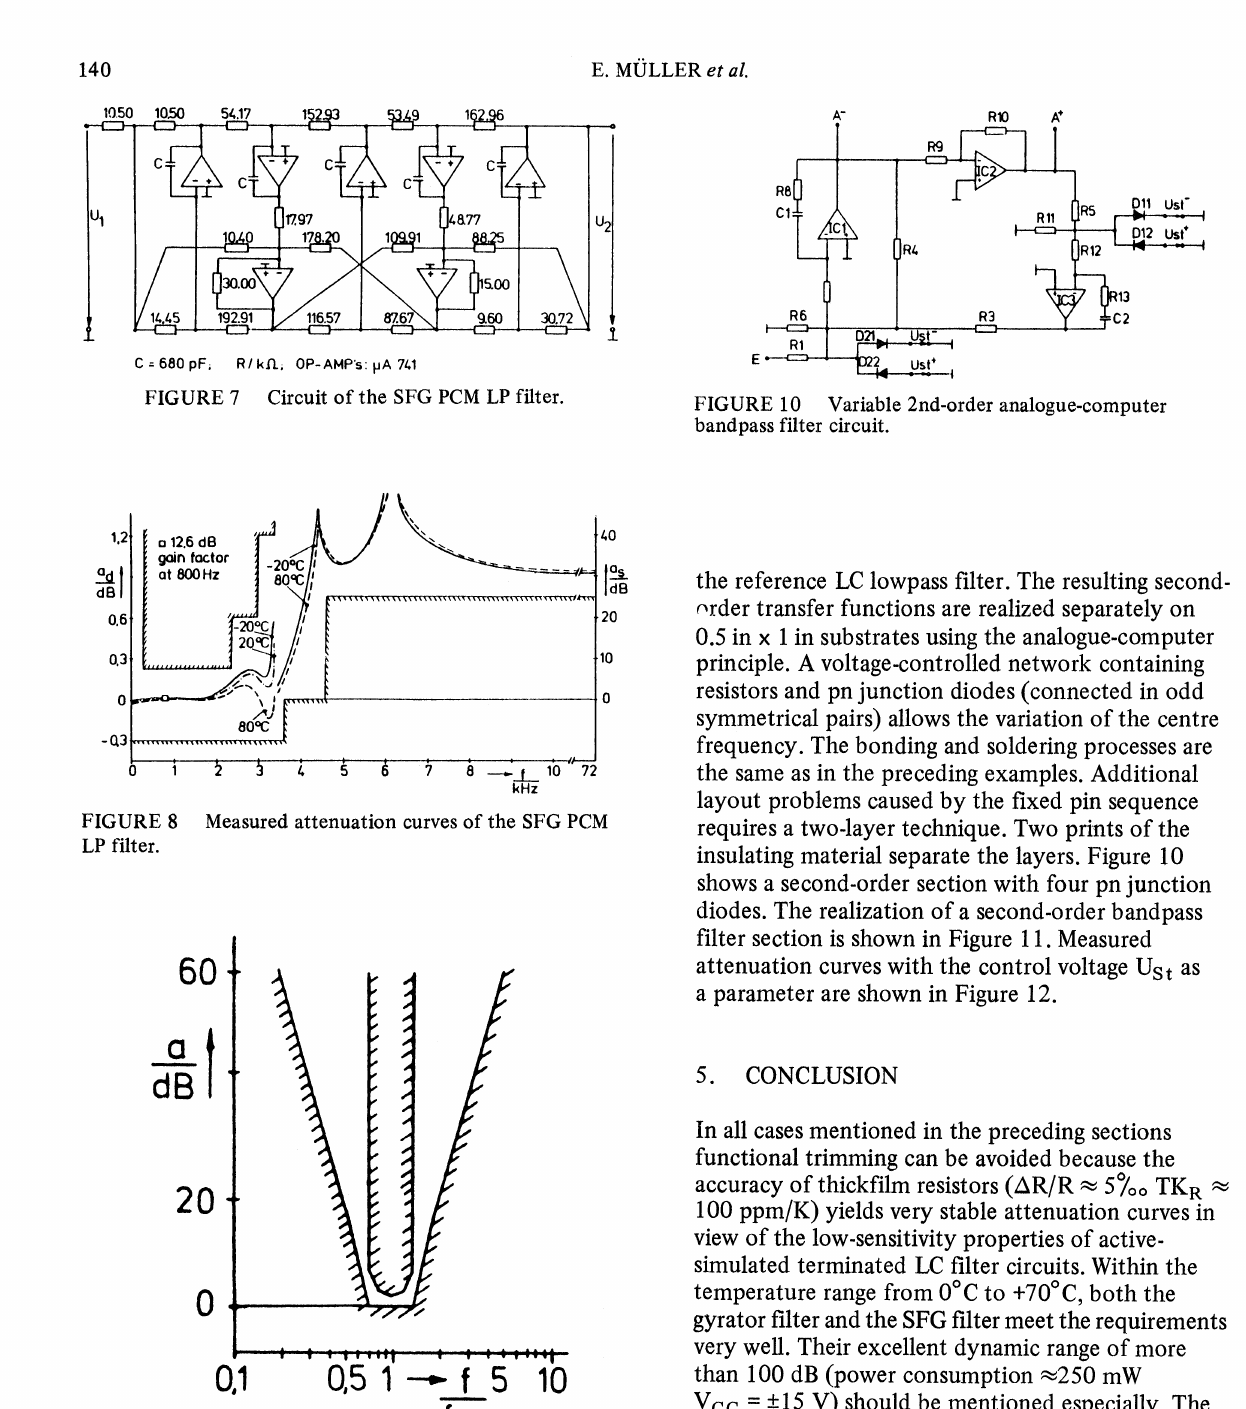
FIGURE 9 Attenuation requirements for octave filters (DIN 45